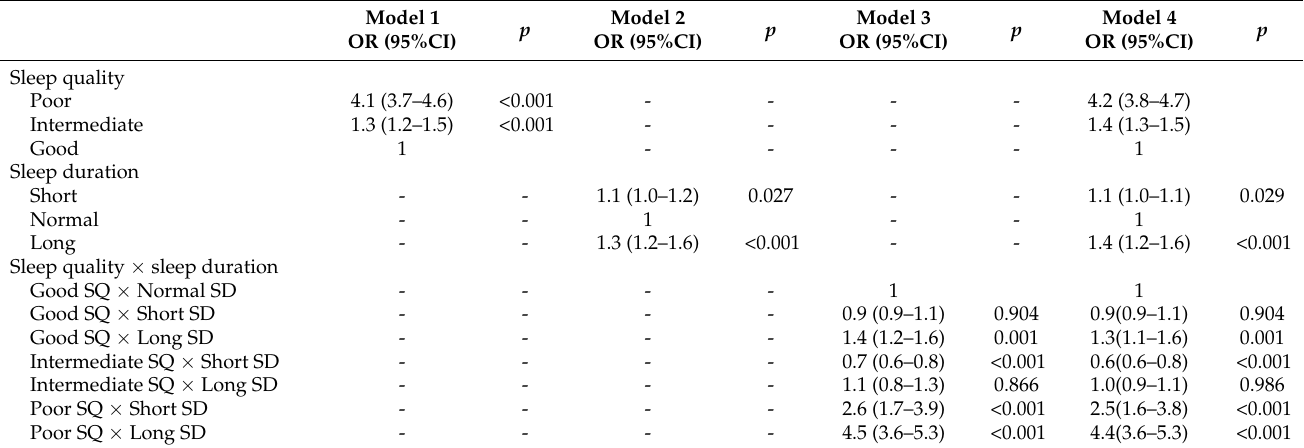
Table 2. Association among sleep duration, sleep quality, and